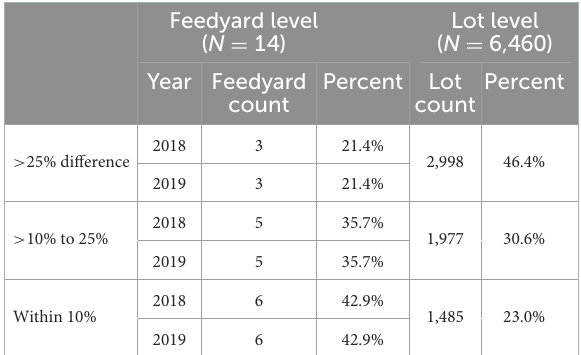
TABLE 3 The percent difference between nDCD and Reg, expressed as a percent of the Reg value, for all indications